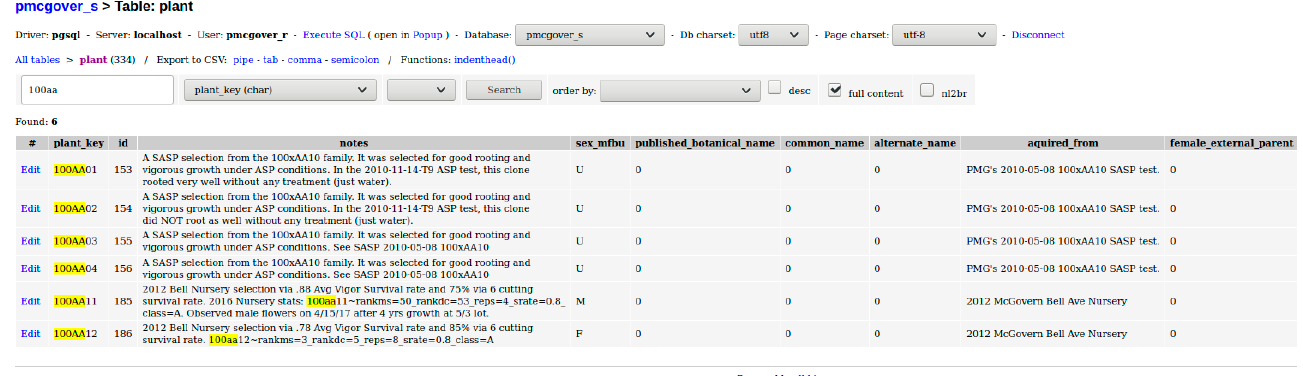
Figure 2. The Open4st Online Database: Plant Table Listing.